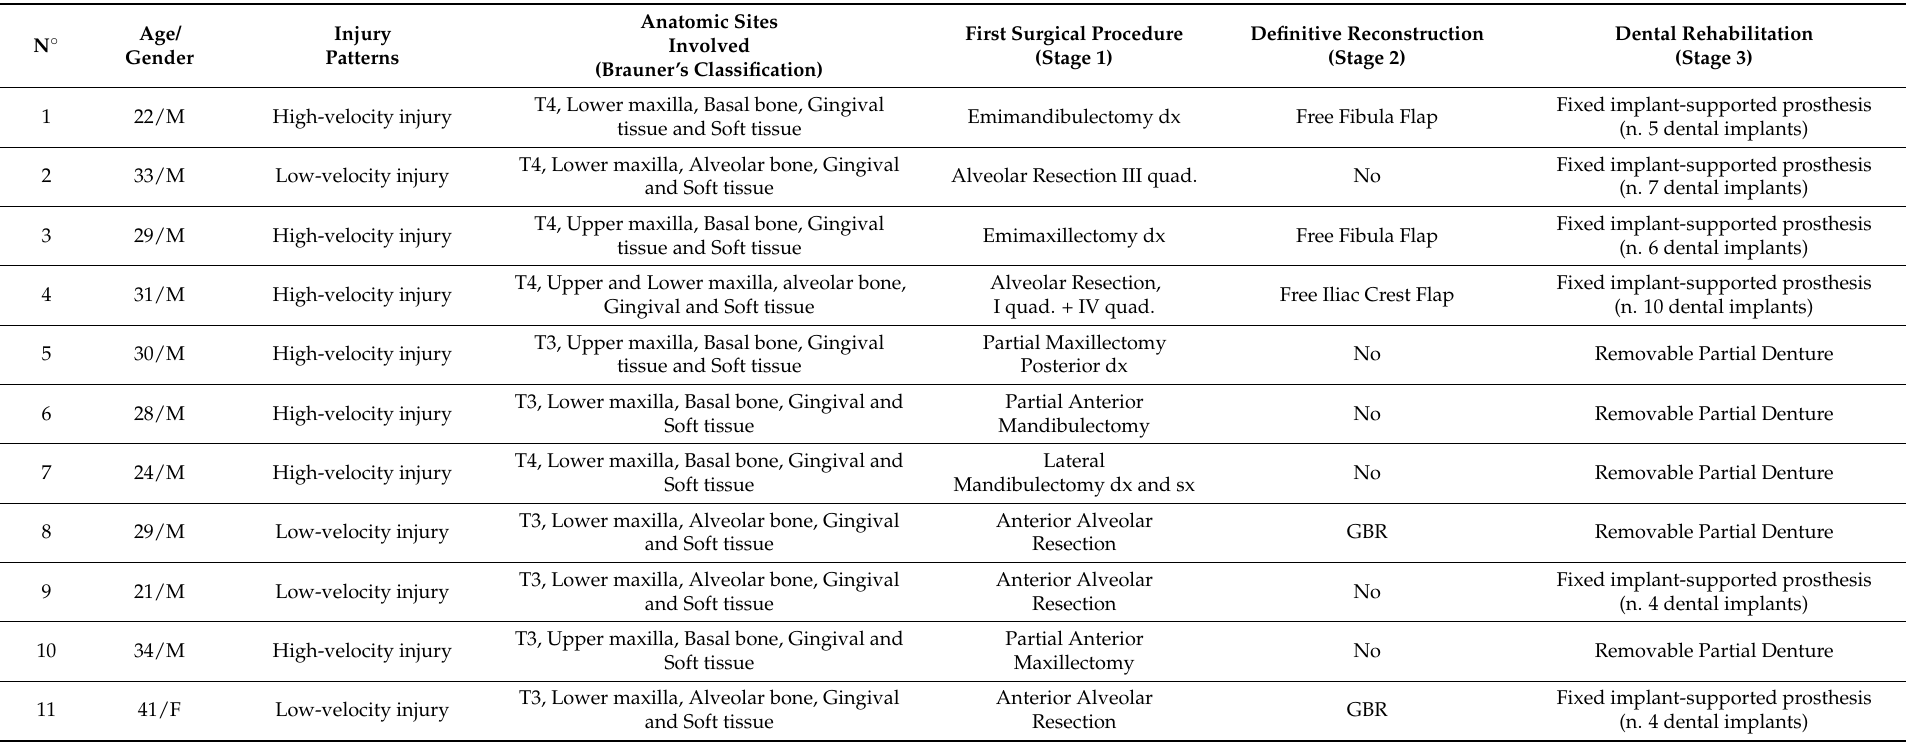
Table 1. Sample characteristic, injury patterns, anatomic sites involved, surgical treatment, and dental-rehabilitation